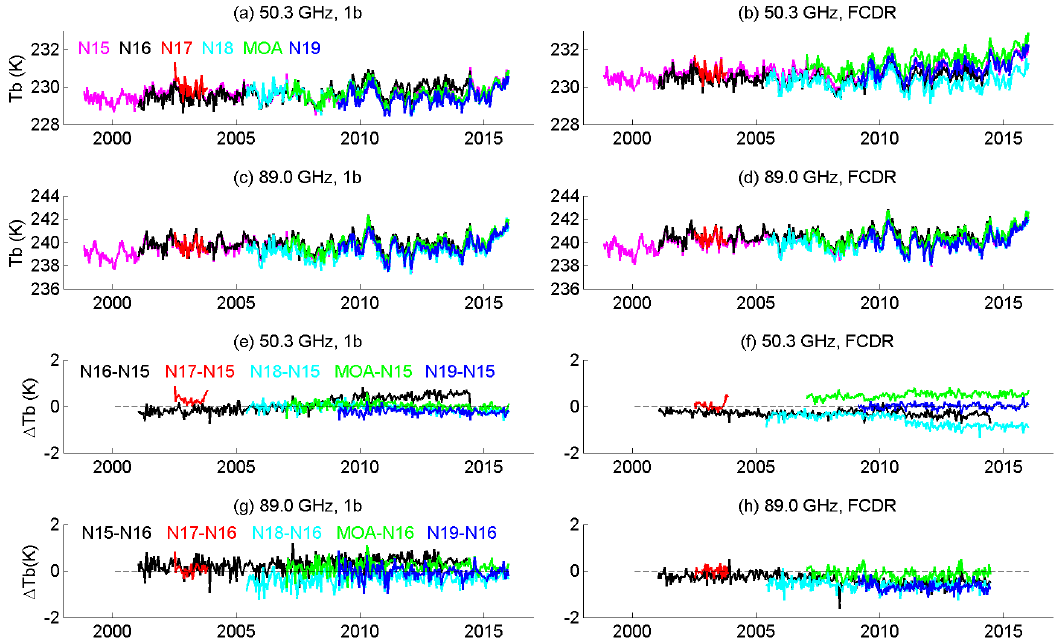
Figure 10. Tropical ocean mean Tb ( a – d ) and ∆ Tb ( e – h ) for 50.3 and 89.0 GHz channels. Left panels display the values of 1b before inter-satellite calibration, while the right panels are FCDRs after inter-satellite calibration. Table 6. Standard deviation of Tb difference of specified channels and satellite pairs, before and after inter-satellite calibration a . Before After Before After Channel